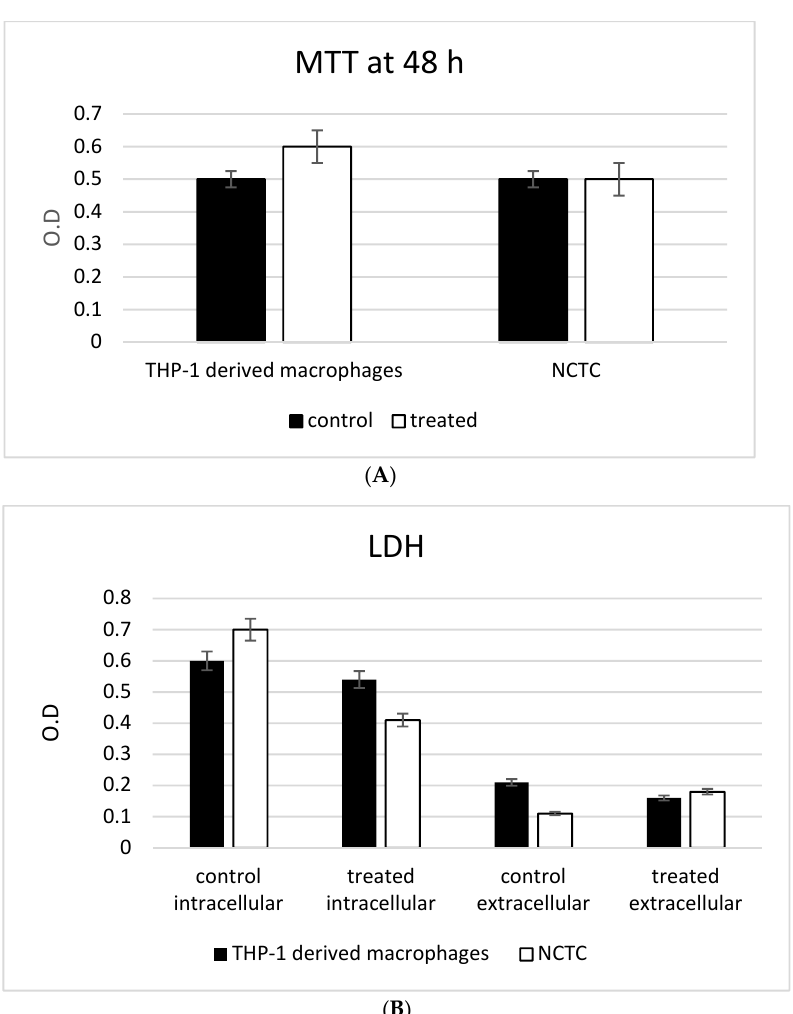
Figure 3. ( A ) Cell proliferation results of MTT assay. In the graph are reported absorbance values for MTT assay on THP-1 and on NCTC L929 after 24 h incubation with and without ADNVs ( B ) Graphic representation of LDH activity inside and outside the cell, after 24 h of incubation with and without the ADNVs. No statistically relevant difference was found.